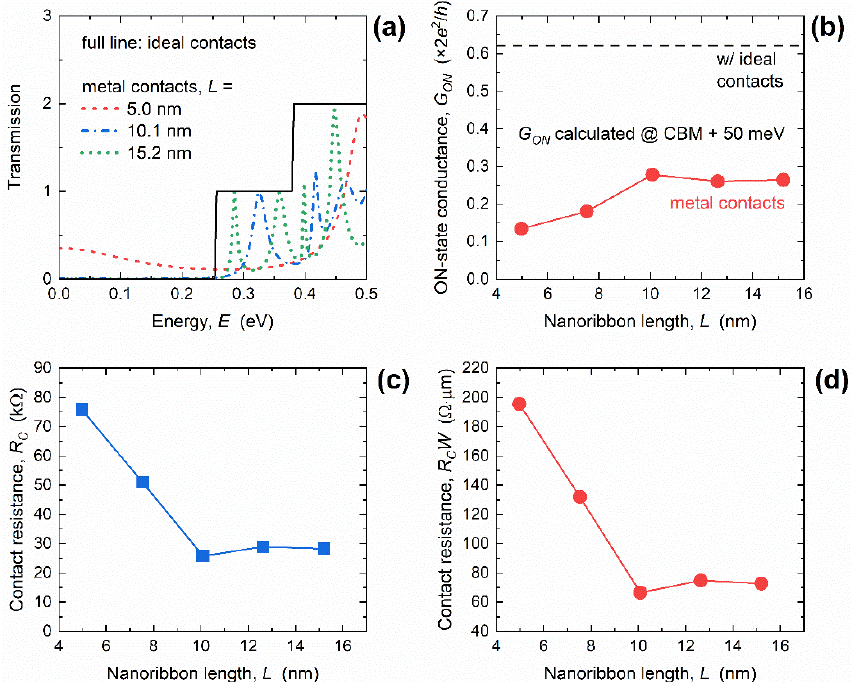
Figure 6. ( a ) Length-dependent transmission in GNRs with ICs and MCs. Impact of length scaling on ( b ) ON-state conductance, ( c ) contact resistance, and ( d ) width-normalized contact resistance. In all cases, W = 2.6 nm.